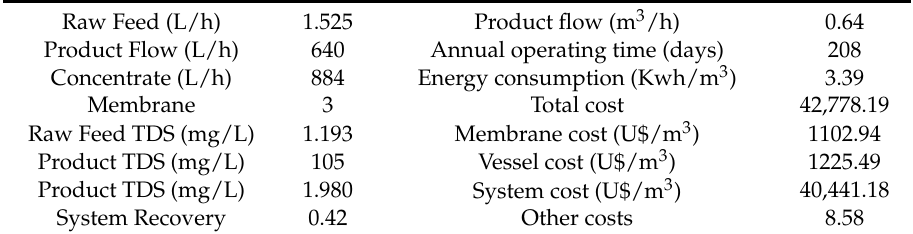
Table 2. Data for the RO membrane 1 design simulation 2 based on PAD-proposed parameters.